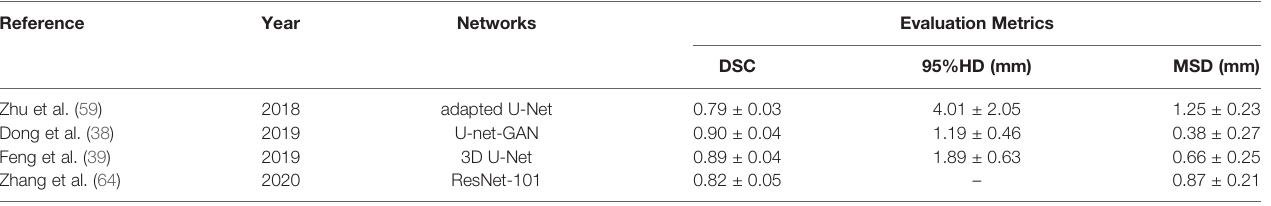
TABLE 4 | Comparison of selected works on segmentation of spinal cord.